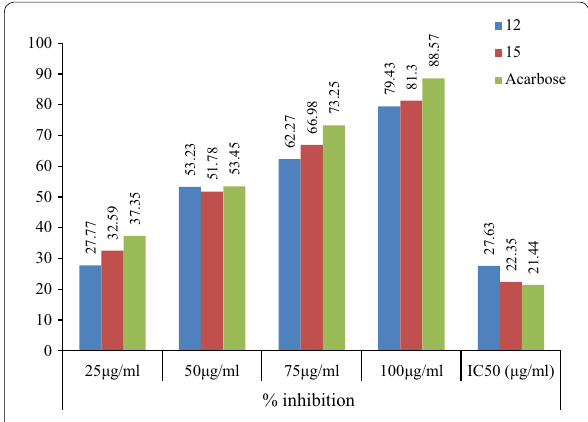
Fig. 3 Graph of potent antidiabetic compounds 12 and 15